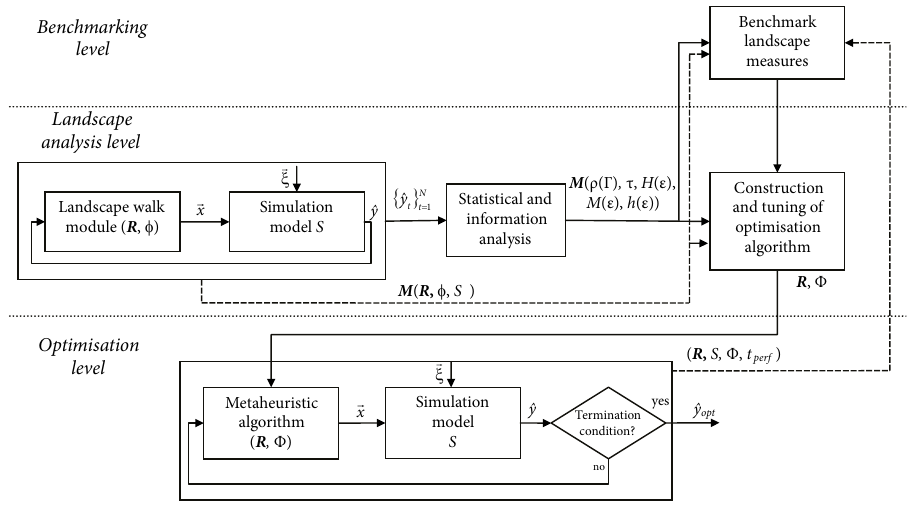
Fig. 1. Simulation optimisation with fitness landscape